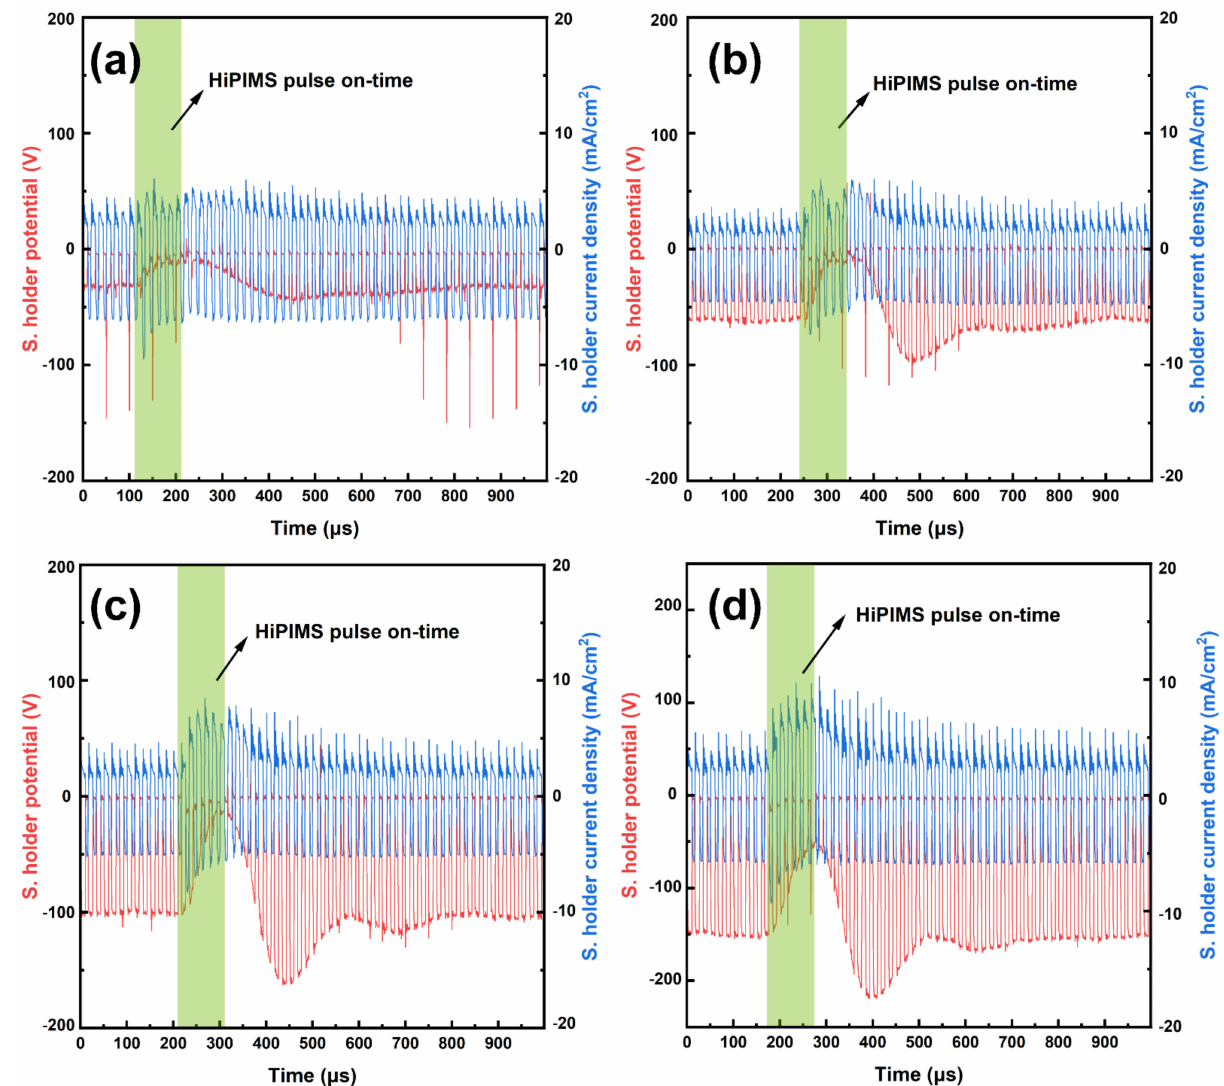
Figure 6. The substrate potential and substrate current density with V s = − 100 V. ( a ) − 30 V, ( b ) − 60 V, ( c ) − 100 V, and ( d ) − 150